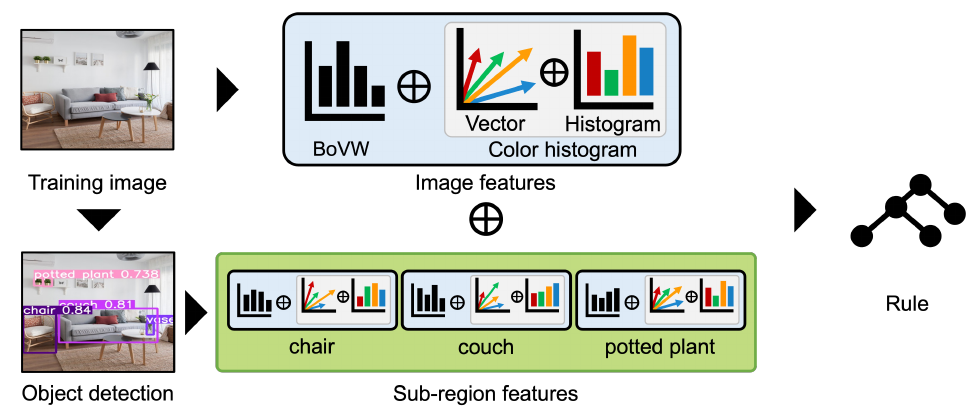
Figure 3. Overview of the proposed